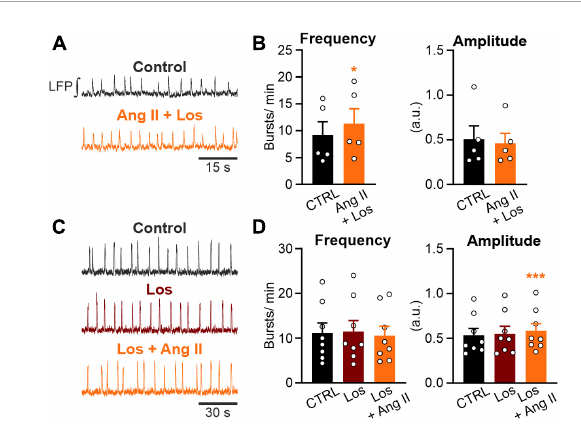
FIGURE3 Ang II increases rhythmic activity in an AT1R-dependent manner. LFP recordings in the preBötC in rhythmic acute brainstem slices. (A,C) Example traces of the integrated LFP for each condition. Control condition was recorded for 15 min followed by a 20 min treatment, except (C) where losartan (Los; 5 µ M) was pre-applied for 10 min. (B,D) Charts show the averaged data of 5 min intervals. CTRL are presented as mean ± SD and were tested using a (B) paired Student’s t -test or (D) a RM one-way ANOVA. * p < 0.05; *** p < 0.001.